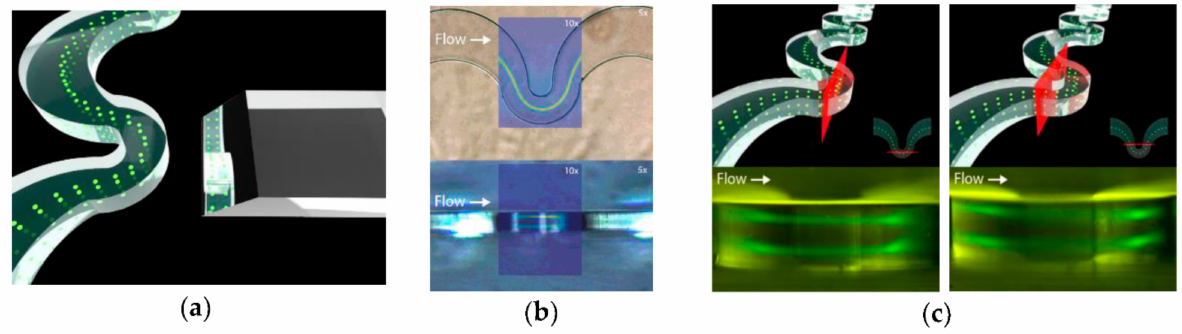
Figure 12. ( a ) Render that illustrates the position of the lateral mirror with respect to the serpentine; ( b ) Zenithal (top) and lateral (bottom) views of the serpentine with an overlapped fluorescence streak image (false color) from inertially focused particles at a flow rate of 130 µ L/min; ( c ) The limited depth of field of the employed objective allows the streak of particles reflected in the mirror to focus on different focus planes (red planes). Reprinted from an open-access source